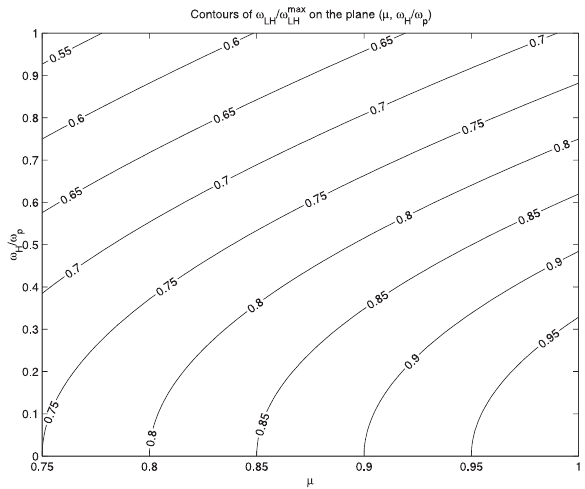
Fig. 12. LHR frequency contours in a densed three component plasma.